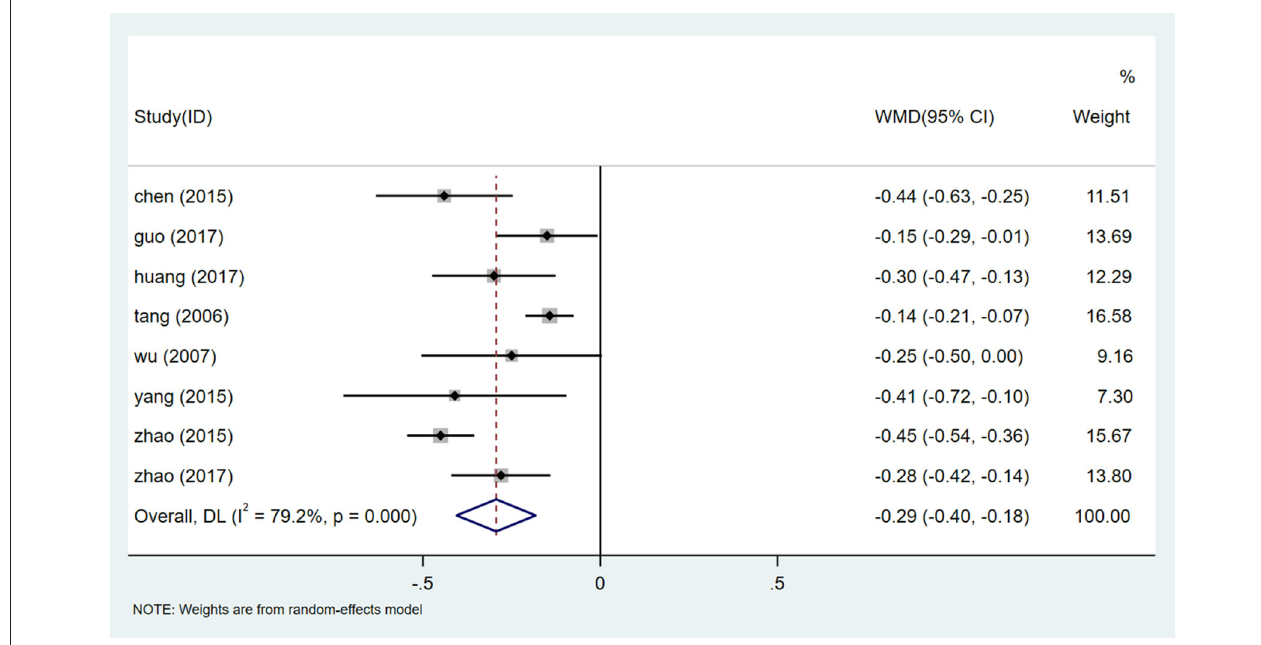
FIGURE 3 | Forest plot of 24h